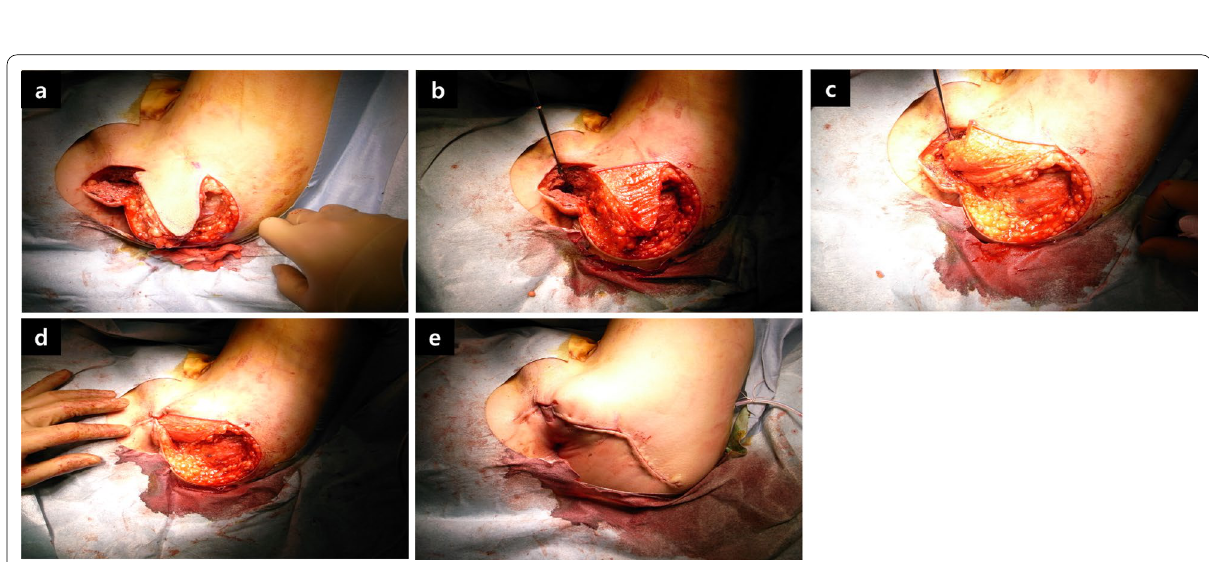
Fig. 4 Formation and insertion of a gluteal local tissue flap. a Triangular design of the local tissue flap. b Triangular local tissue flap after its epidermis had been dissected. c The flap was interposed between the urethra and rectum, and fixed proximally to the fistula site. d The flap fits well with no deformation or bulge. e A closed suction drain was placed below the wound, and the surgical field closed with interrupted